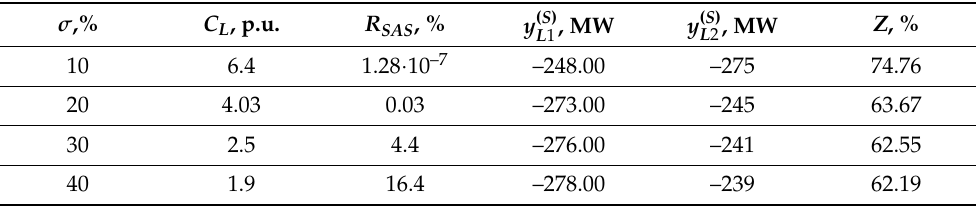
Table 1. Dependence of the parameters of the limiting mode on the standard deviation σ of the load capacities.